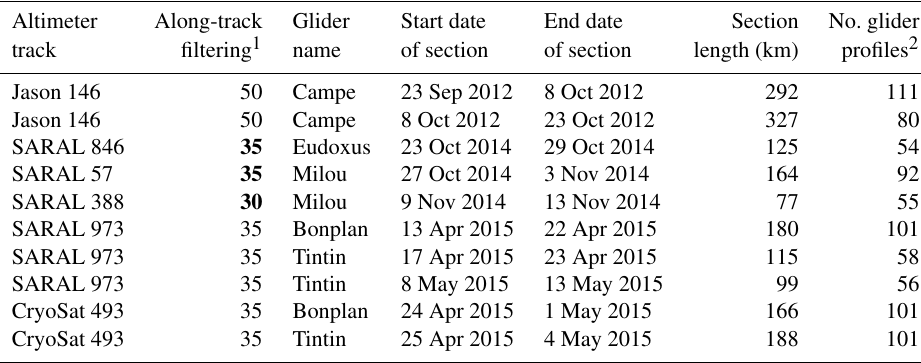
Table 2. Characteristics of the co-located glider and altimeter track sections. Altimeter Along-track Glider Start date End date Section No. glider track filtering 1 name of section of section length (km) profiles 2 Jason 146 50 Campe 23 Sep 2012 8 Oct 2012 292 111